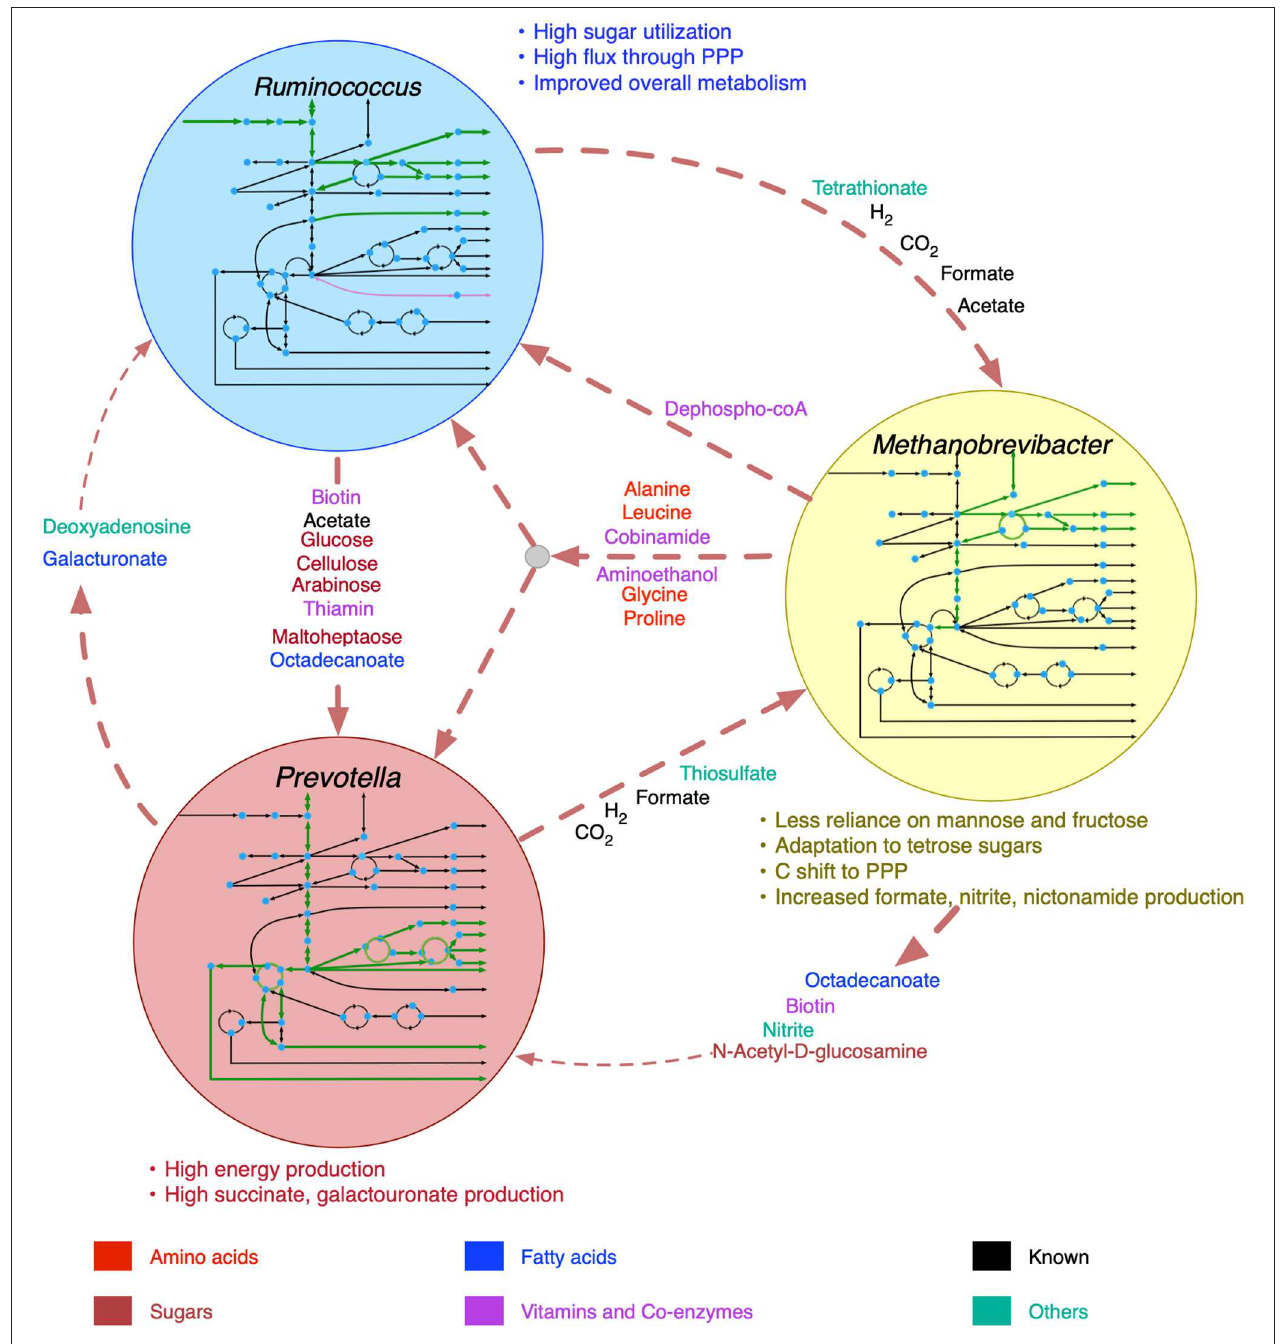
FIGURE 5 | Shifts in metabolism and inter-species interactions after the inclusion of viral auxiliary metabolic genes. Inside the circles for each organism, increase in pathway fluxes are shown in thicker green lines and decrease in pathway fluxes are shown in purple lines. Decreased metabolic transactions are shown in thinner dashed